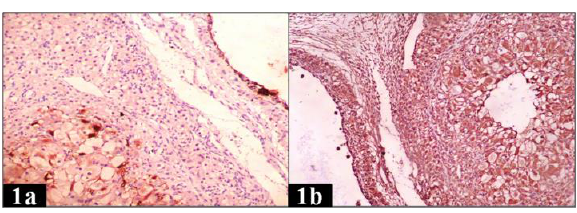
Fig 1. IHC expression of CK AE1/AE3 and vimentin in normal ovary (a) Surface epithelium showing 3+ and granulosa cells showing 2+ CK immunostaining (100X) (b) Surface epithelium showing 1+ and granulosa cells showing 3+ vimentin immunostaining (400X) In the normal ovary, pancytokeratin was positive with high intensity on the surface epithelium, with mildly appreciable vimentin reactivity. Vimentin 3+ was observed in endothelium, granulosa cells of ovarian follicle and ovarian cortical stroma.